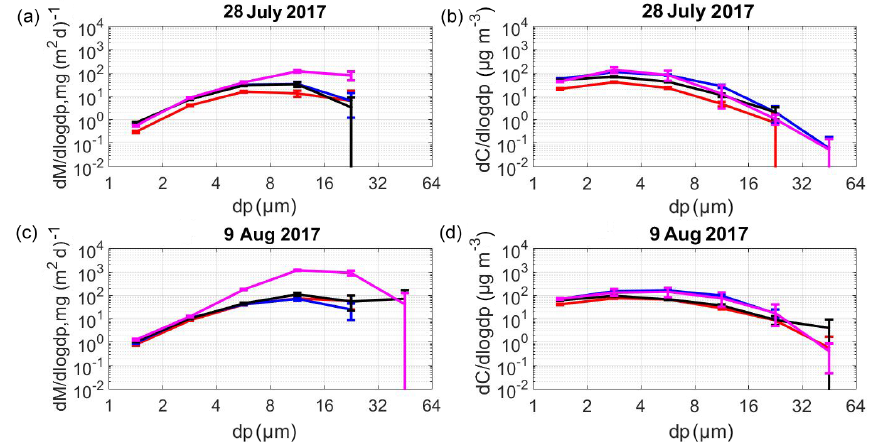
Figure 10. Comparing different samplers with respect to (a, c) dust mass deposition rates and (b, d) dust mass concentrations calculated from application of the corresponding model as function of particle size. Different colors indicate different samplers (red: flat plate; blue: Sigma-2; black: BSNE; magenta: MWAC). The bars show the central 95% confidence interval of the daily variation. Corresponding deposition models for concentration calculation are given in Table